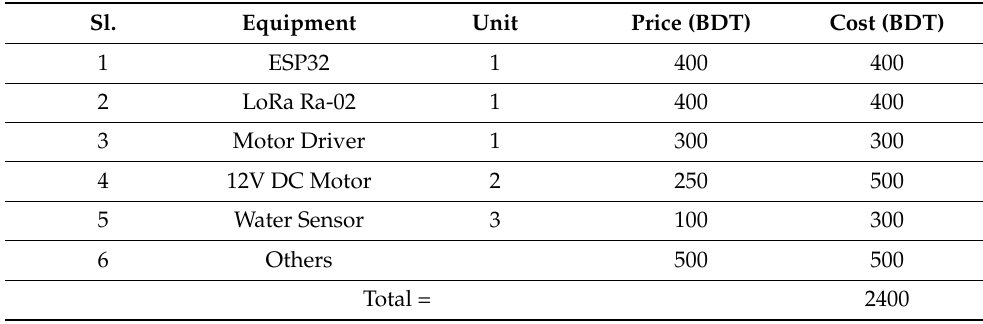
Table 2. Cost estimation for one set of hardware.